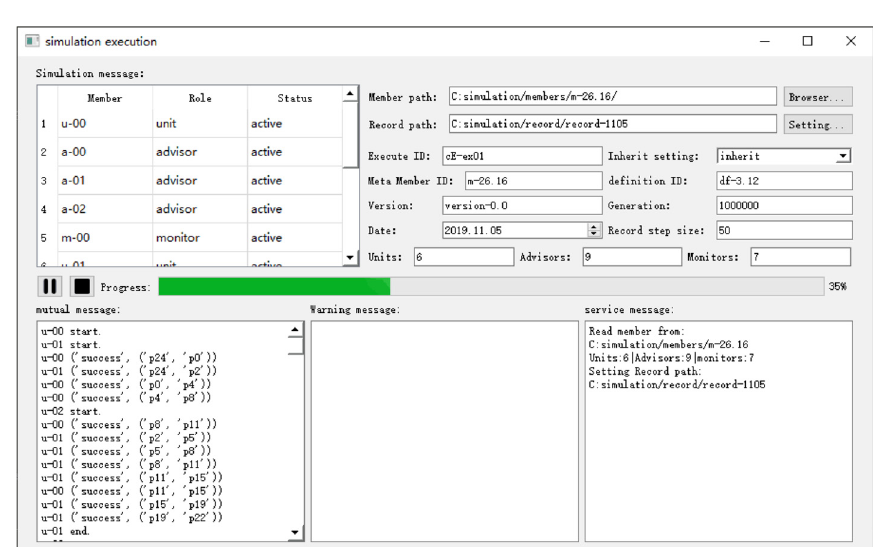
Figure 14. Simulation round method de fi nition interface